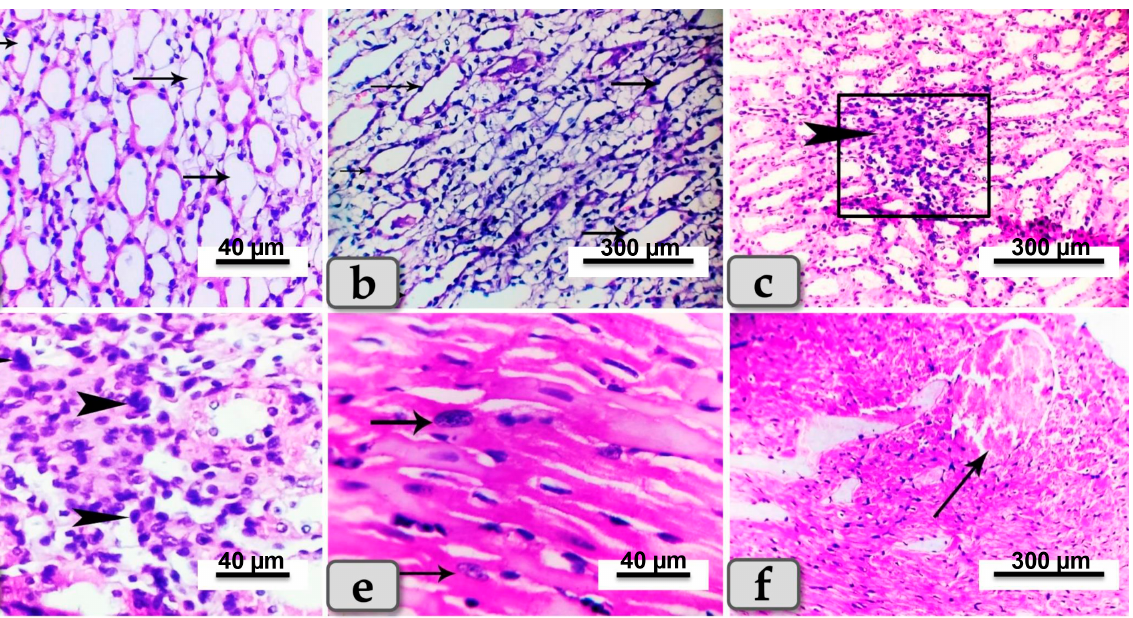
Figure 6. Photomicrographs of kidneys sand hearts from rats suffering diabetes and treated with SeNPs (Group 3). ( a ) Showing cystic dilation of a few renal tubules (arrows). ( b ) Showing cystic dilation of a few renal tubules (arrows) with hyaline casts inside. ( c ) Showing focal infiltration of inflammatory cells in renal medulla (arrow head). ( d ) Higher magnification of the previous figure demonstrating the infiltrated inflammatory cells (arrow head). ( e ) Photomicrograph of the cardiac myocytes showing proliferation of Anitschkow cells (arrows). ( f ) Showing blood vessel dilatation and congestion (arrow). Stain: All H&E.